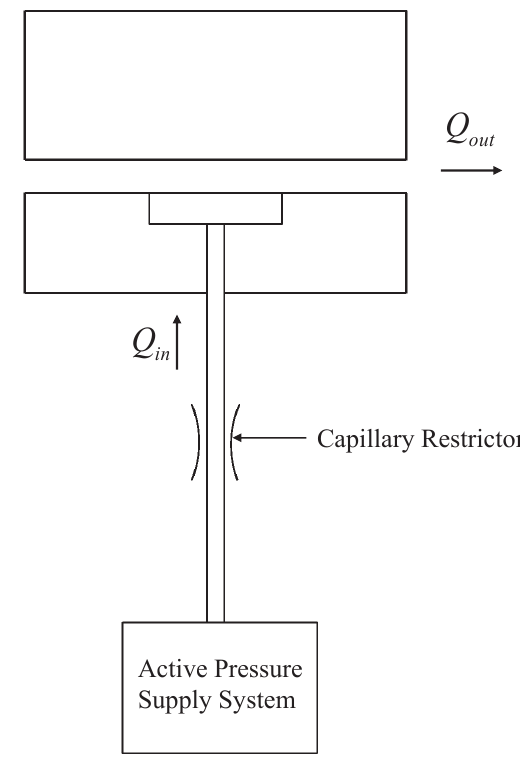
Figure 3. Externally pressured hydrostatic bearing compensated with a capillary